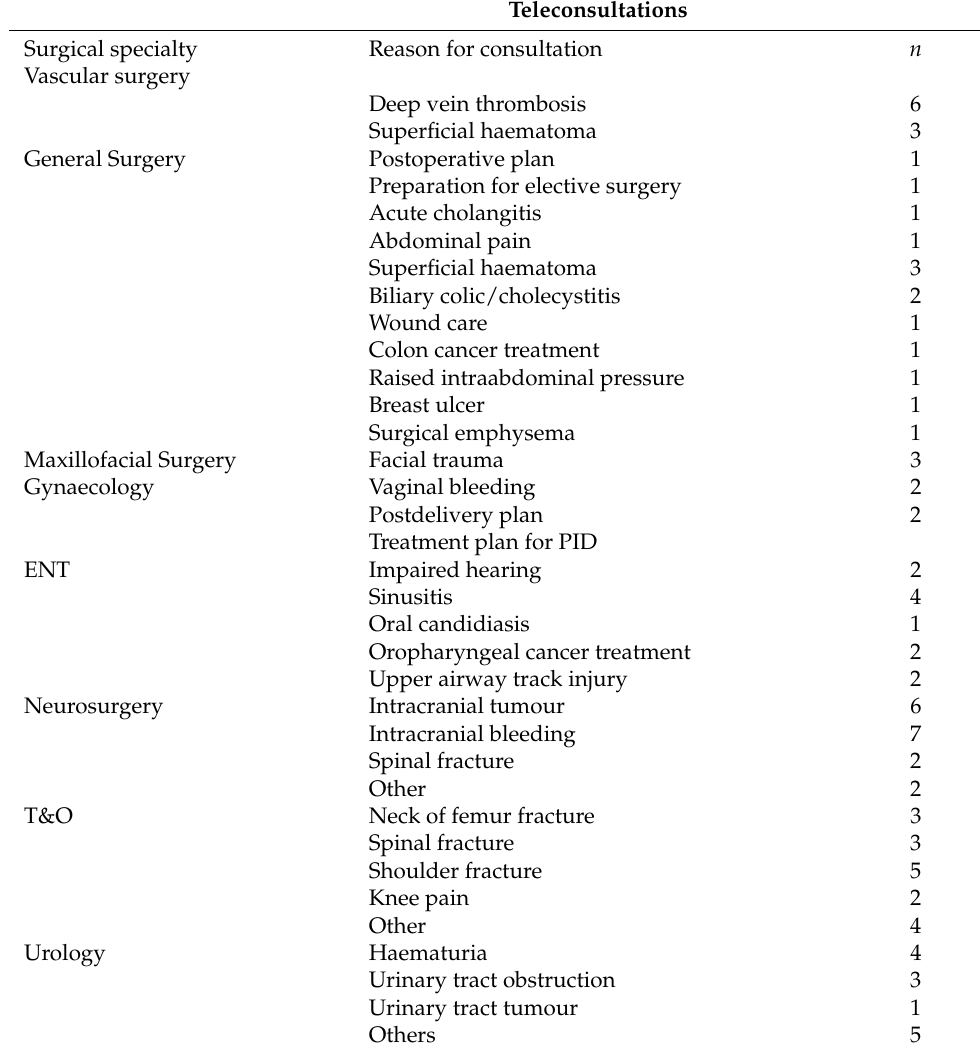
Table 2. Most common reasons for teleconsultation and standard face-to-face consultation by surgical specialty. There were no missing